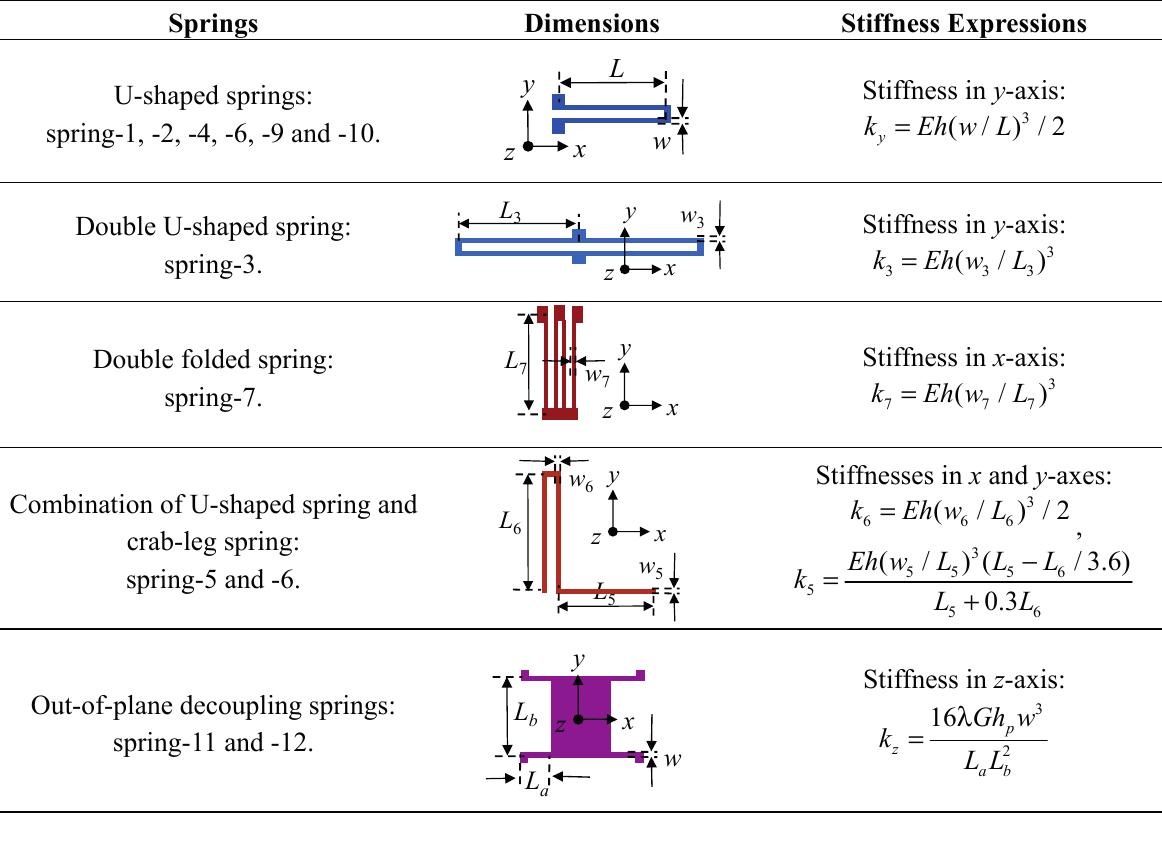
Table 3. The stiffness expressions of different